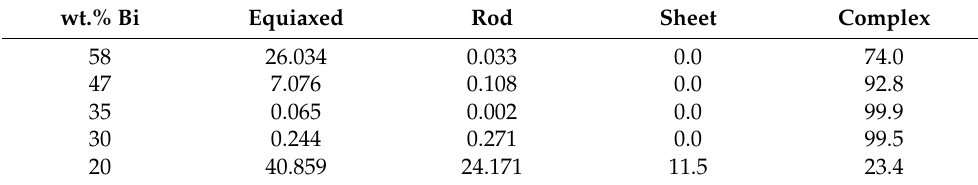
Table A2. Volume fraction of morphologic